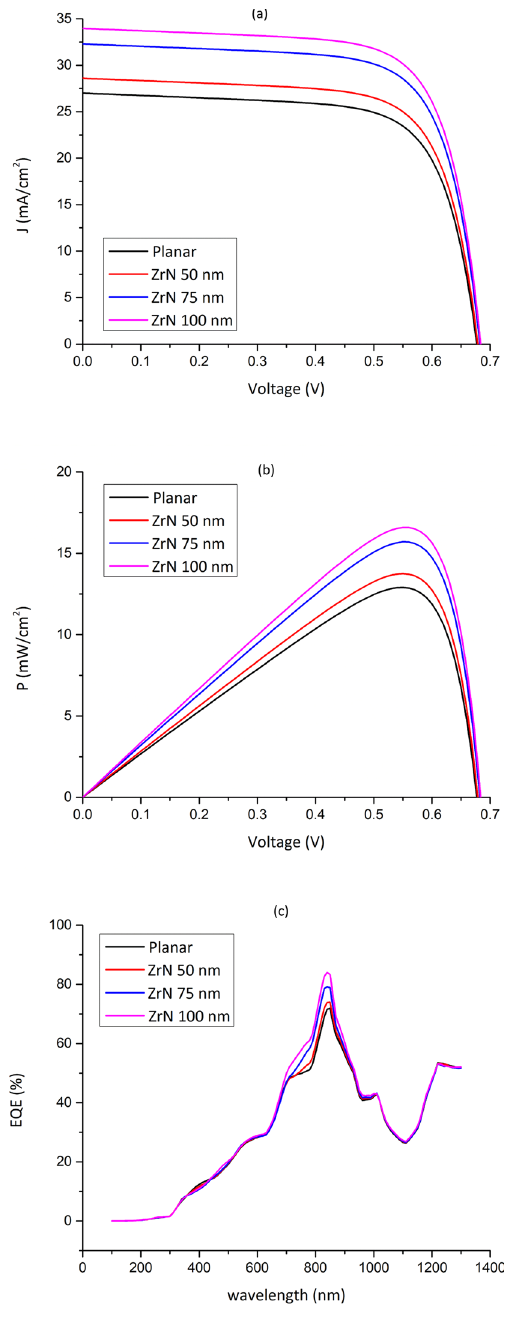
Figure 8. ( a ) J-V , ( b ) P-V , and EQE characteristics of the proposed